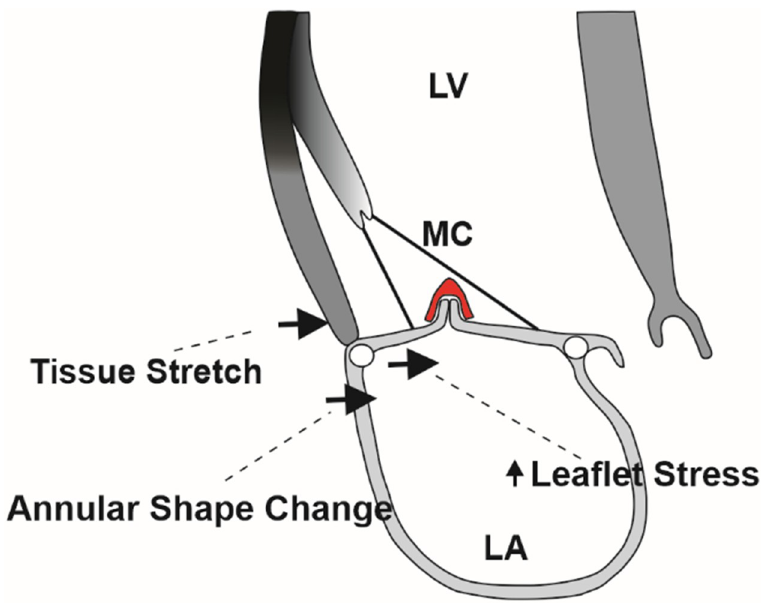
Fig 8. Diagram of the proposed mechanical effects of MitraClip application. The black arrows represent displacement of the posterior leaflet, lateral annulus and lateral sub-valvular LV wall caused by MitraClip application. The effects are to increase leaflet stress, decrease the septo-lateral annular dimension and stretch the sub-valvular myocardium. LV–left ventricle, LA–left atrium, MC–MitraClip.